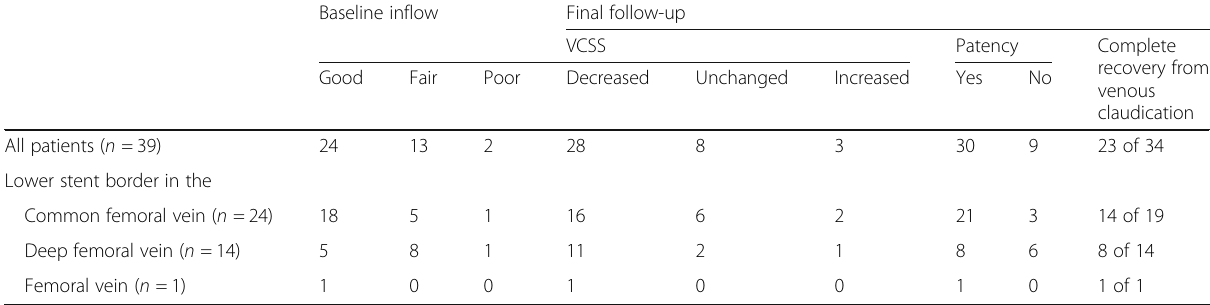
Table 3 Infrainguinal stent placement; baseline inflow, clinical results, and patency at final follow-up Baseline